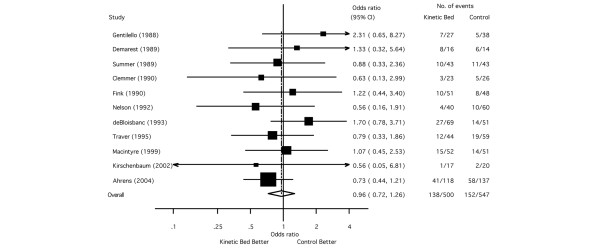
Forest plot showing the effect of kinetic bed therapy on mortality. CI, confidence interval.